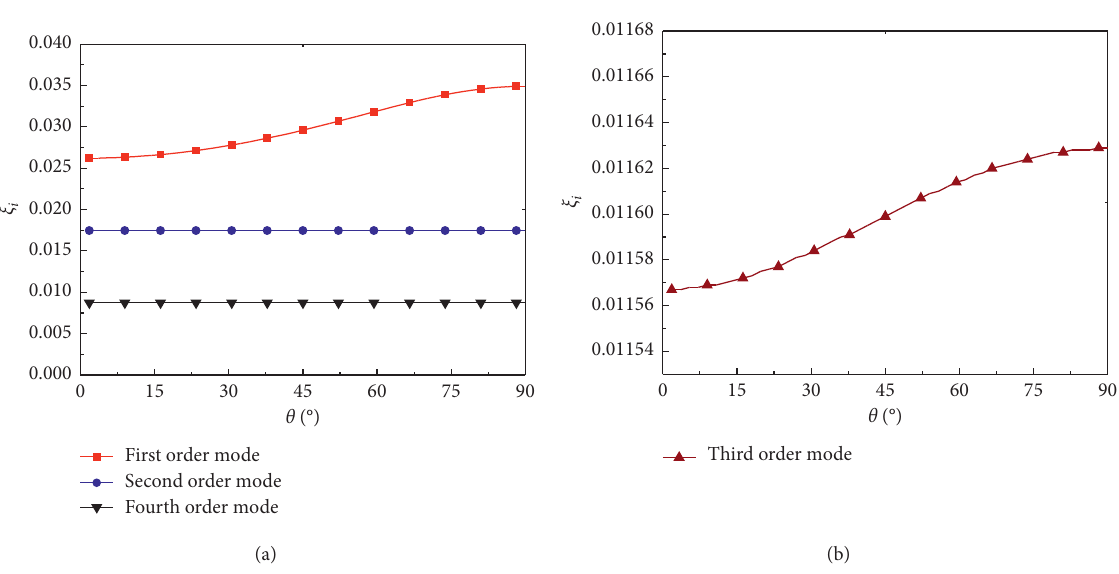
Figure 2: Relationship between in-plane modal damping ratios and inclination of tether.